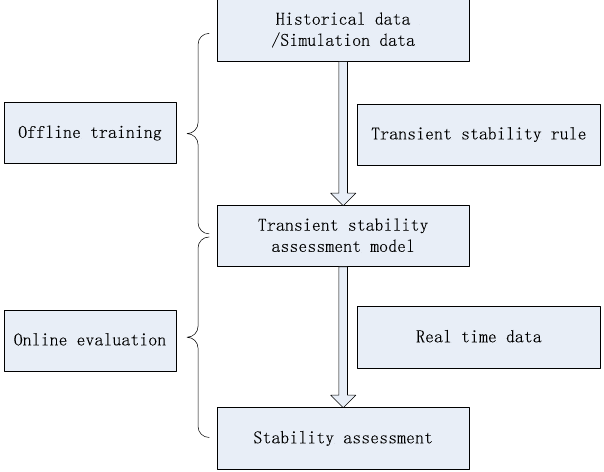
ffl ine training and online Figure 3. Combination model of offline training and online evaluation. Figure 3. Combination model of o Figure 3. Combination model of offline training and online evaluation.